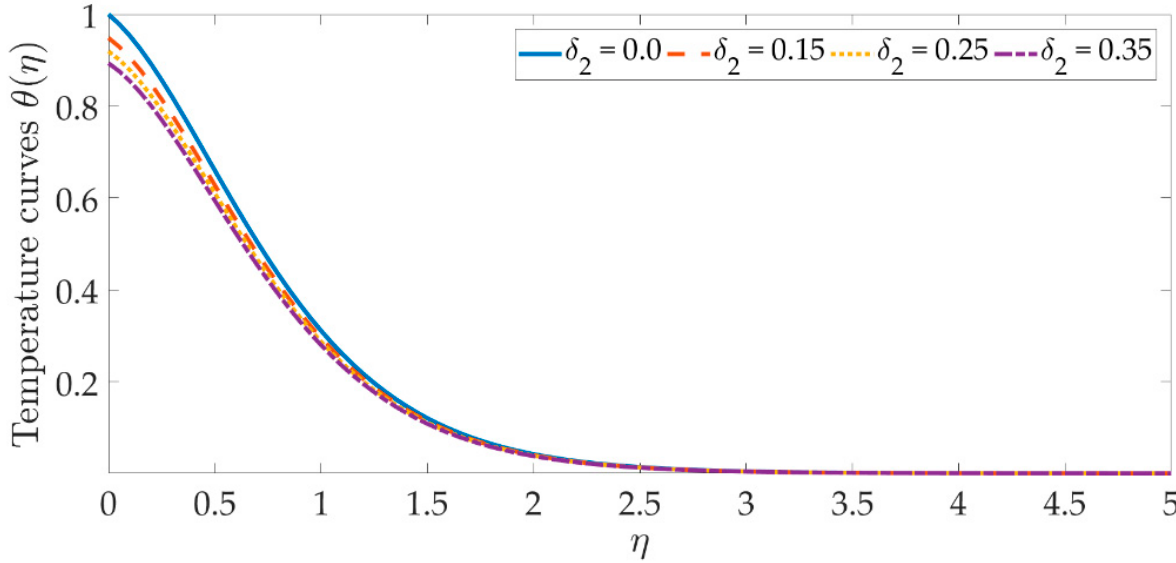
Figure 13. Temperature curves against the multiple values of δ 2